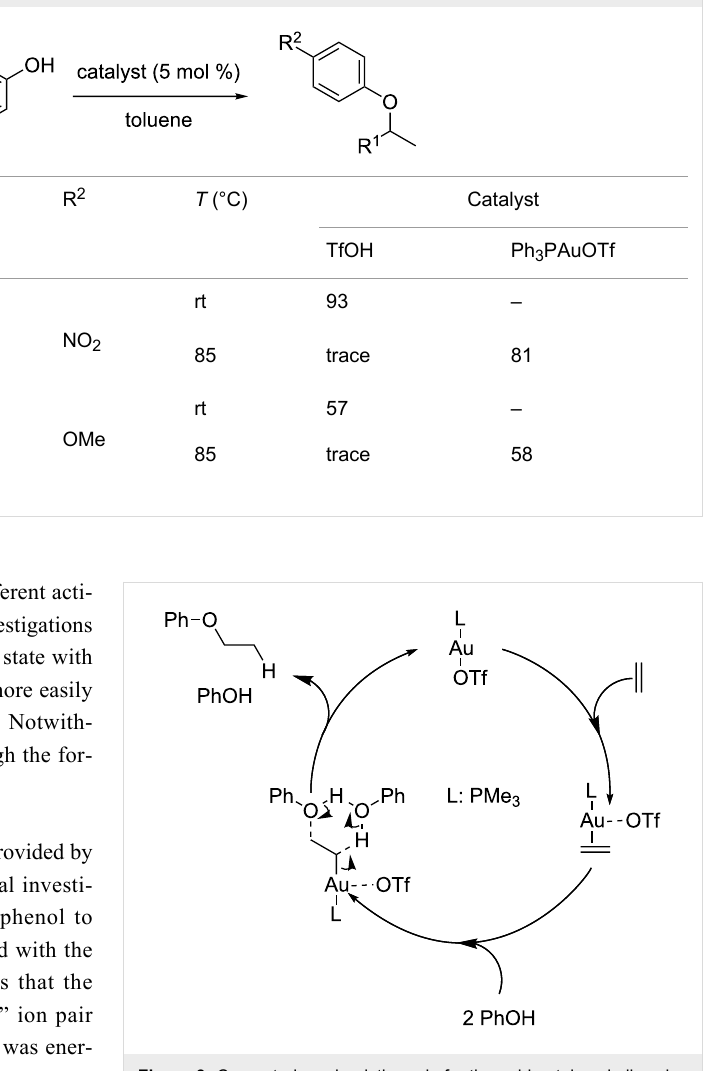
In their seminal works, Yang and He reported on